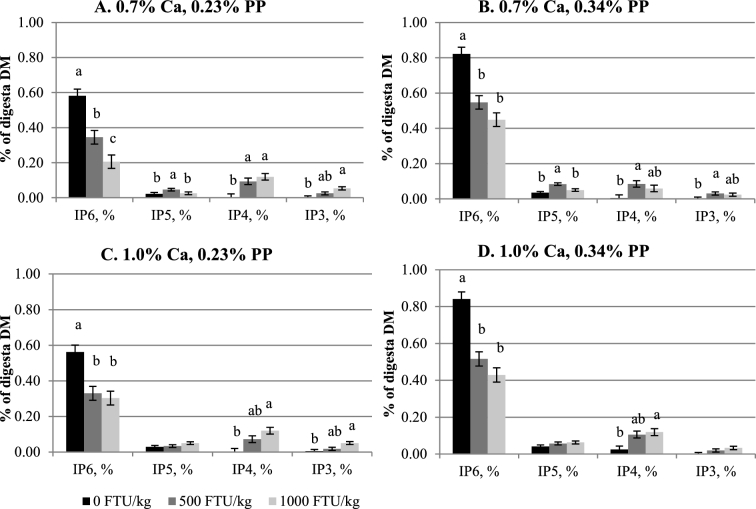
Effect of phytase on inositol phosphate ester (IP3–6) concentrations in crop (mean±SEM). On DM basis, analyzed IP6 and IP5 concentrations were 0.998 and 0.088%, respectively, in low PP basal, and 1.368 and 0.129%, respectively, in high PP basal. No IP3 or 4 concentration was detected in either low or high PP basals. a-c Comparisons were made within the same IP ester group, using Tukey's test. Means with different superscript letters differ.